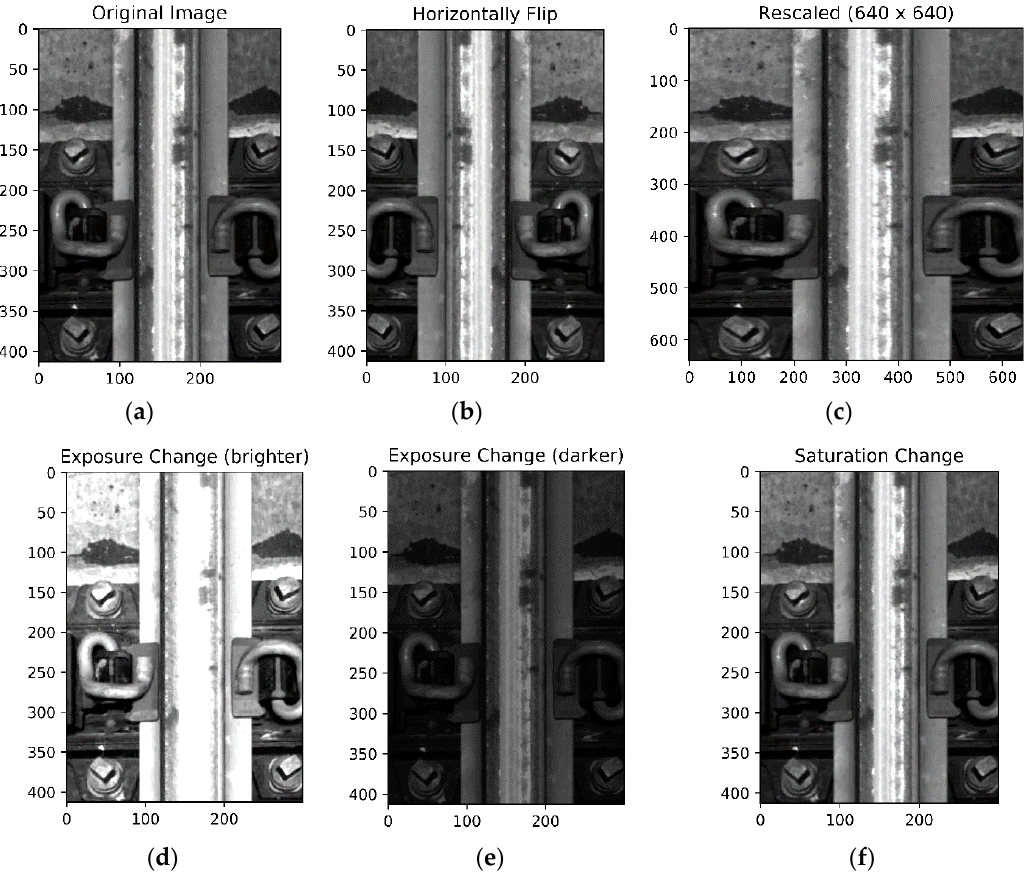
Figure 7. Samples of data augmentation: ( a ) The raw image captured by the image acquisition system; ( b ) The railway track image was flipped from left to right; ( c ) The railway track image was resized to 640 × 640; ( d – f ) Different from the geometric distortions above, the photometric distortions include the exposure and saturation change. Table 1. Labeling information.